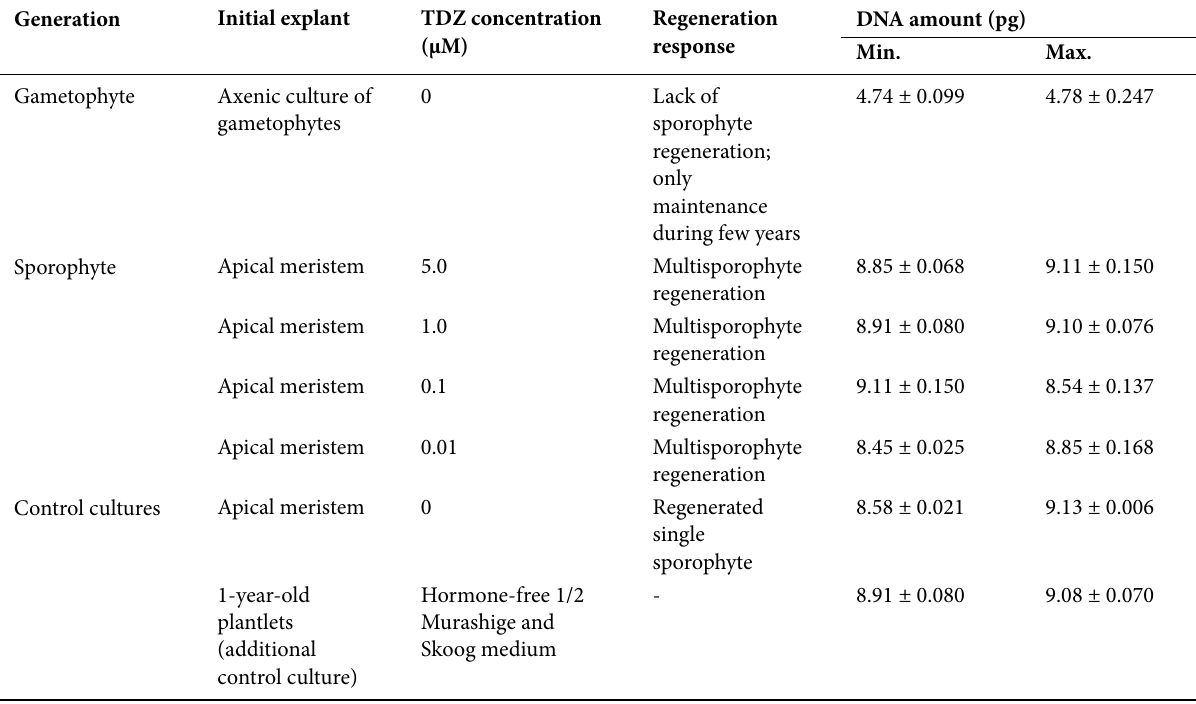
Table 2 Nuclear DNA content* of Cyathea smithii regenerants derived from different regeneration treatments in the presence of various concentrations of thidiazuron [TDZ; 1-phenyl-3-(1,2,3-thiadiazol-5-yl)-urea)].